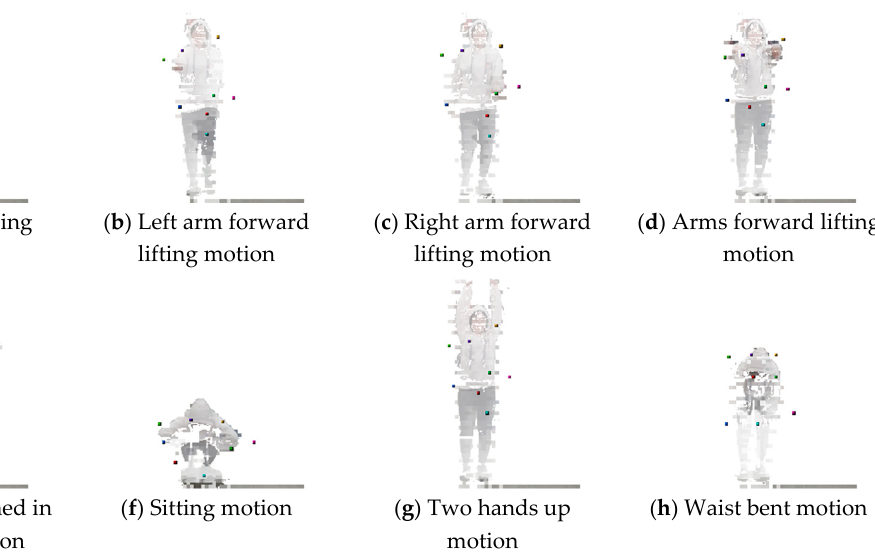
Figure A1. 3D landmarks generated when κ was 8.